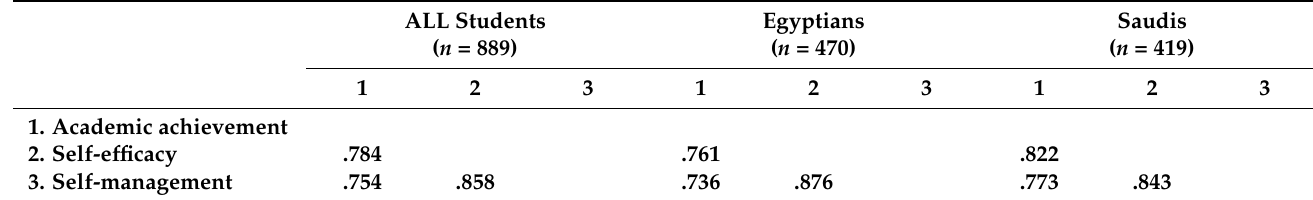
Table 3. Heterotrait–Monotrait Ratio